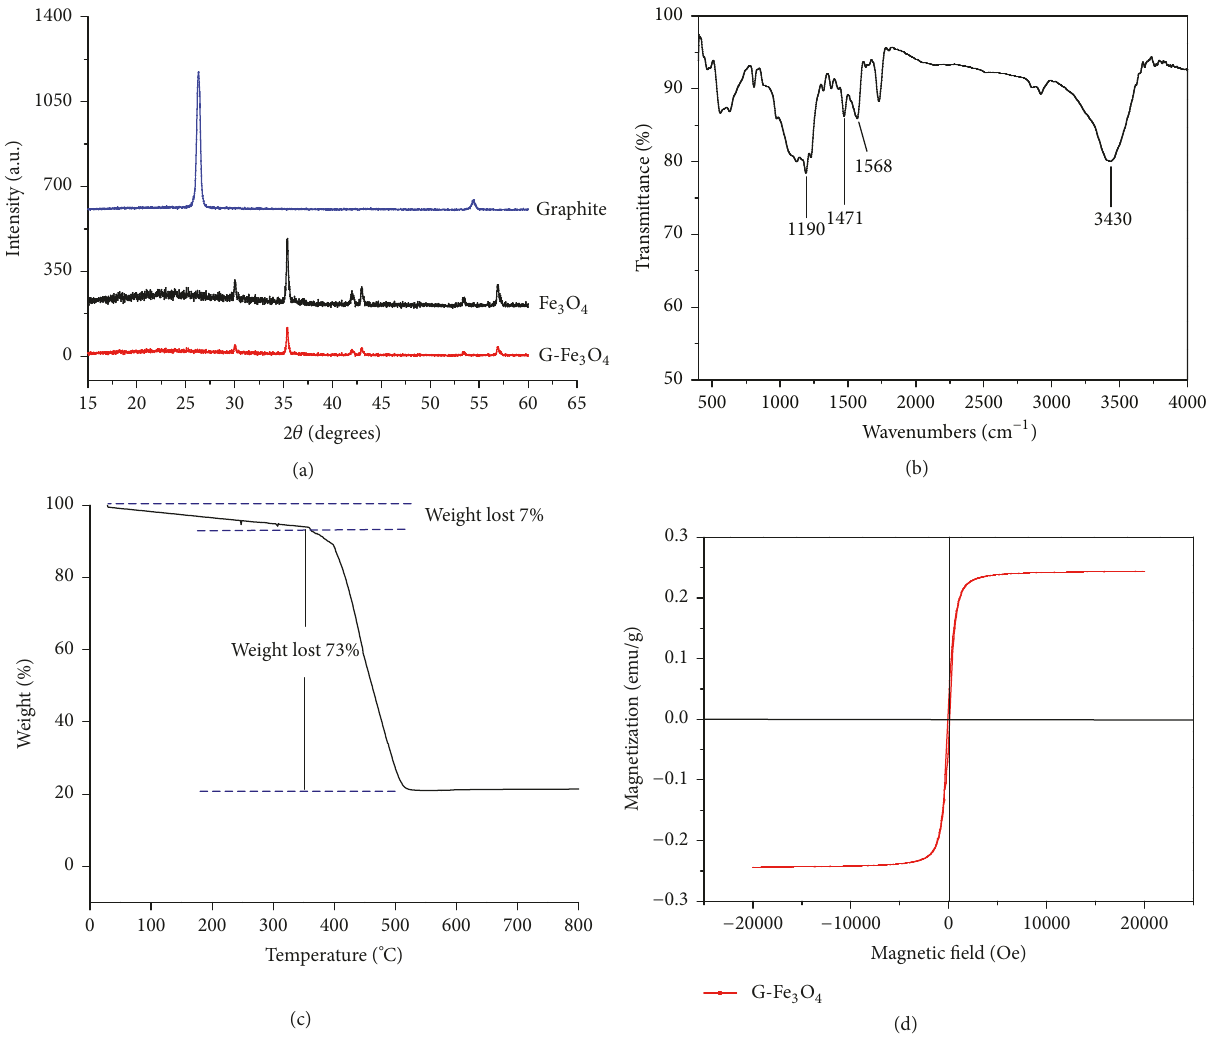
Figure 1: (a) X-ray diffraction (XRD) of graphite, Fe 3 O 4 , and G-Fe 3 O 4 , (b) FT-IR spectra of G-Fe 3 O 4 , (c) thermogravimetric analysis (TGA) of G-Fe 3 O 4 , and (d) VSM magnetization curves of G-Fe 3 O 4